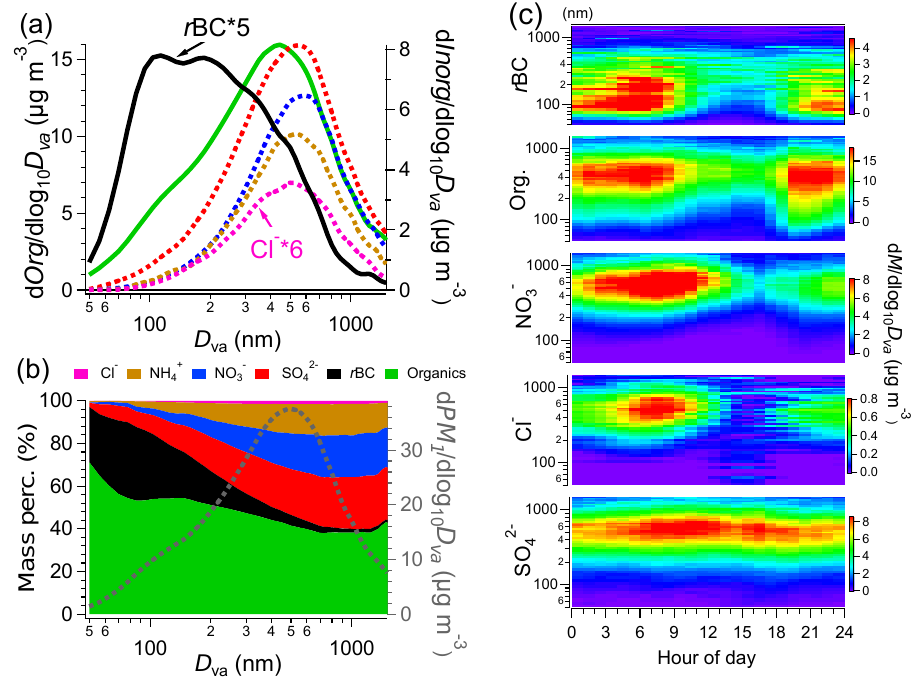
Figure 5. (a) Mass-based average size distributions of organics, r BC (left y axis), sulfate, nitrate, chloride, and ammonium (right y axis) ( D va , vacuum aerodynamic diameter), (b) fractional contributions of the six PM 1 species as a function of particle size (left y axis), and size distribution of total PM 1 (right y axis), (c) diurnal profiles of the size distributions of r BC, organics, nitrate, chloride, and